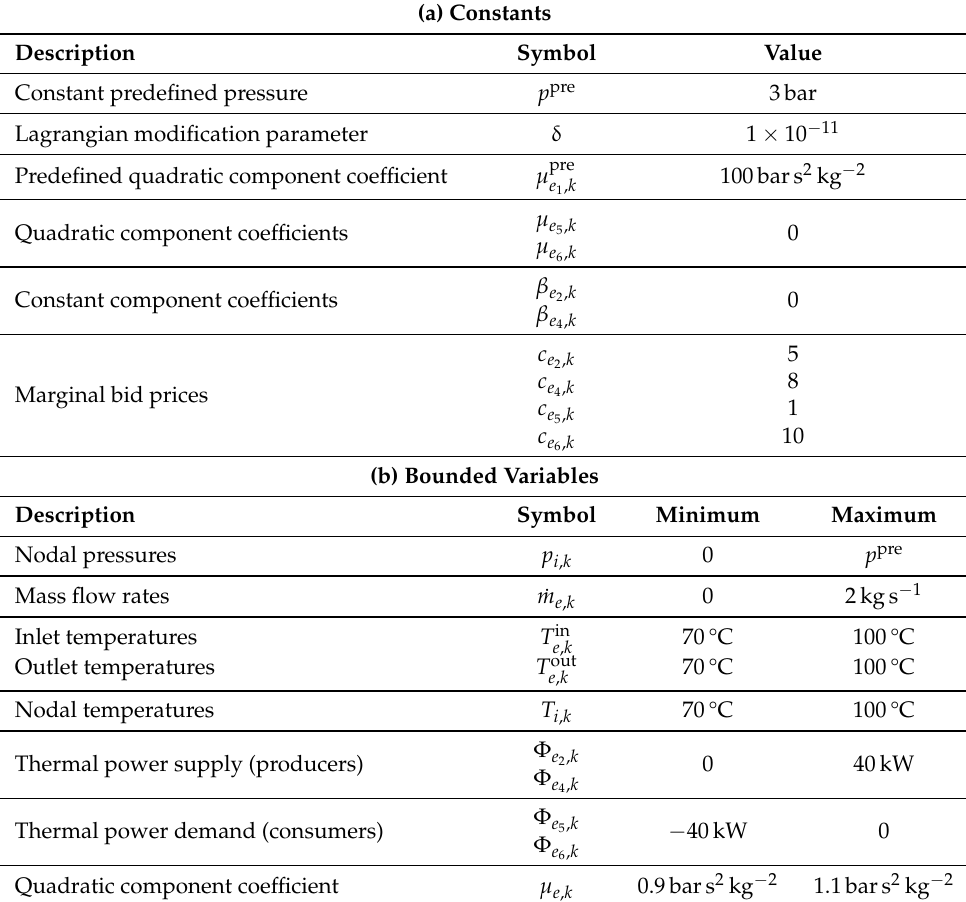
Table 1. The parameters used for simulation. The values are equal for all time steps k ∈ S k . (a)